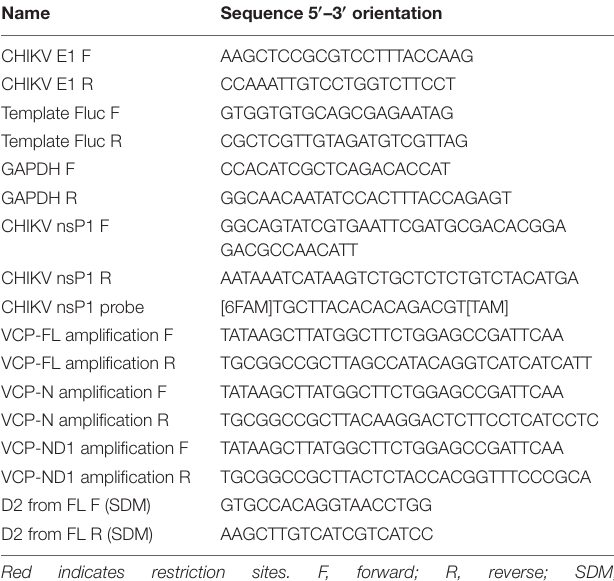
TABLE 1 | Primers used in this study given in 5 (cid:48) –3 (cid:48)